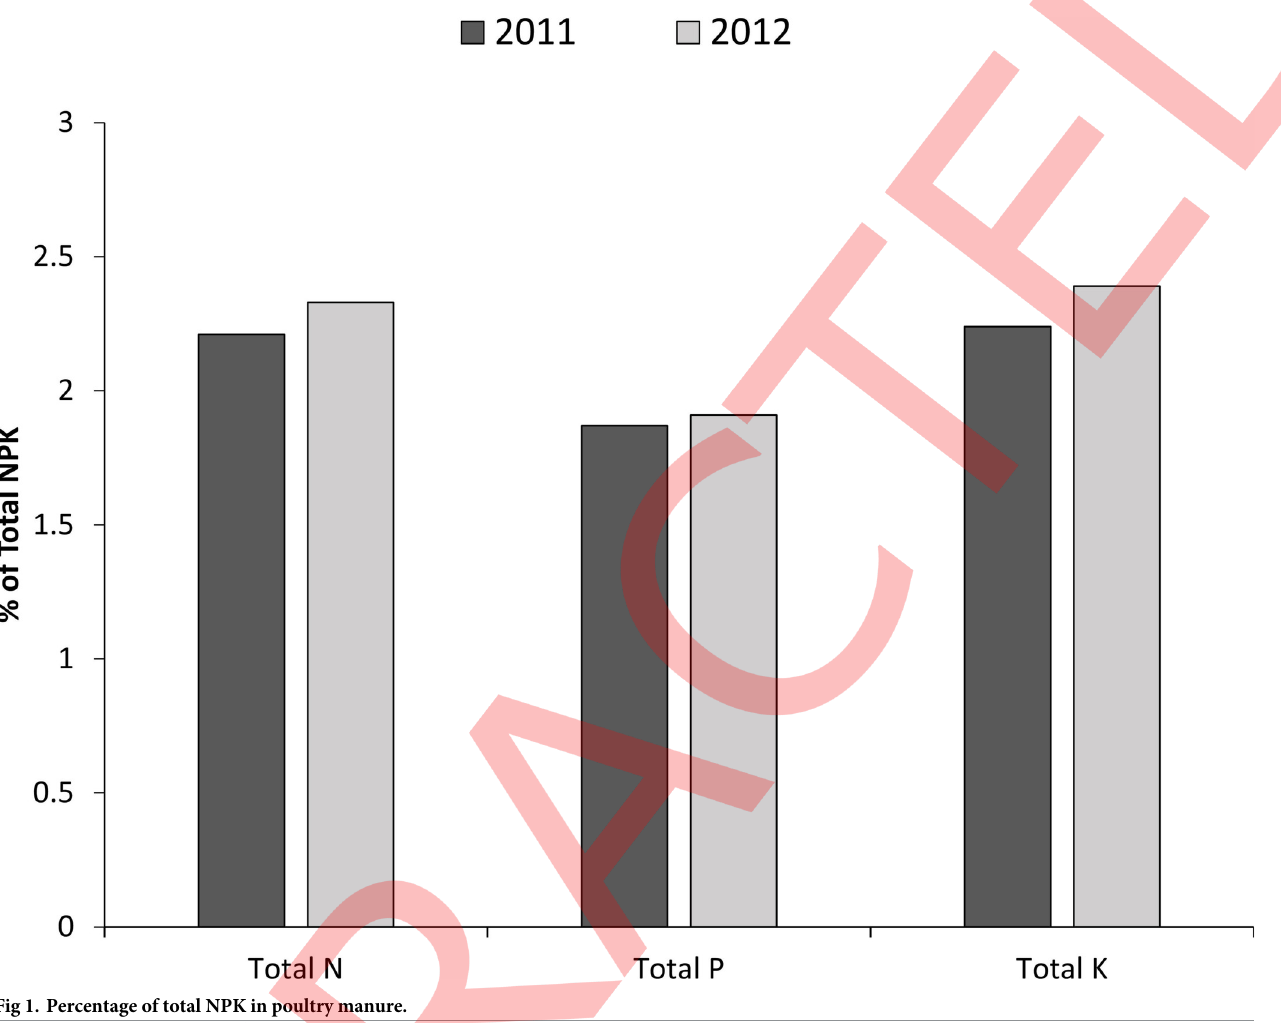
Fig 1. Percentage of total NPK in poultry